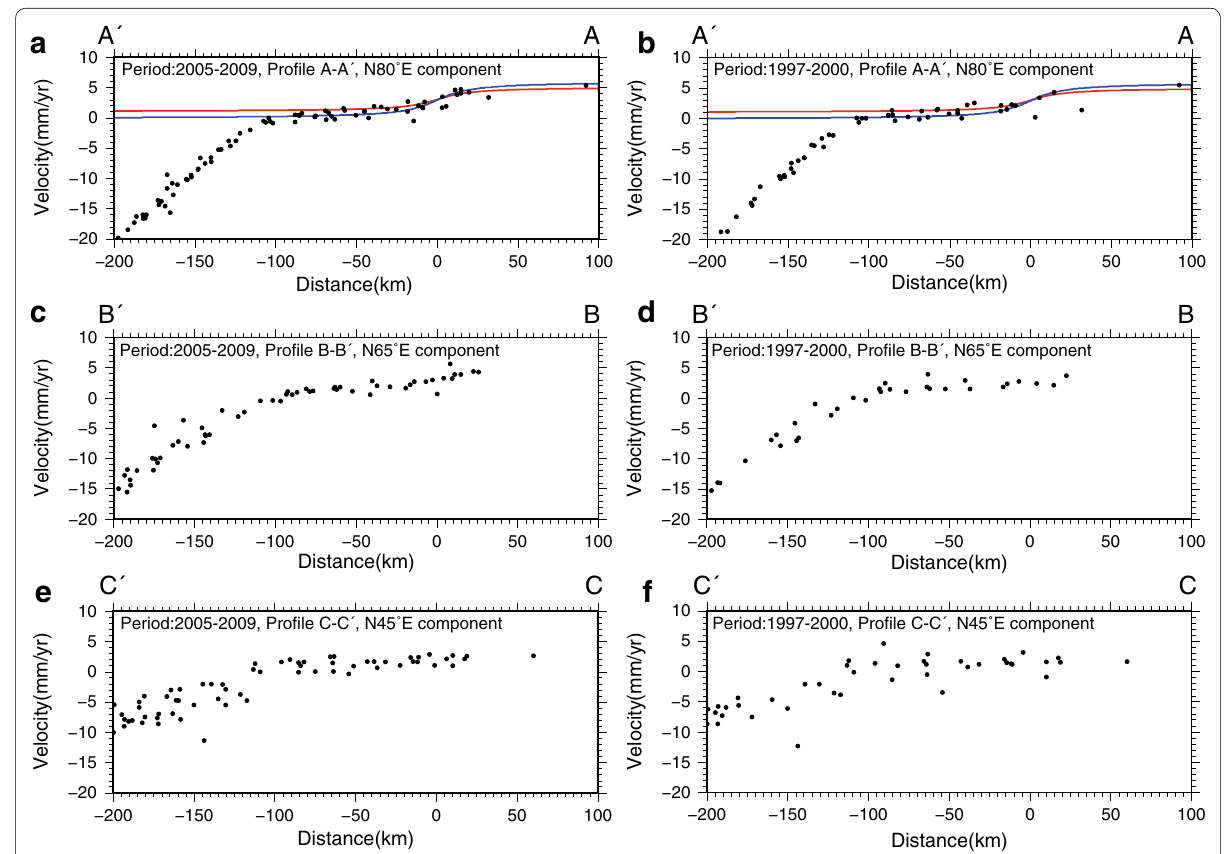
Fig. 2 Velocity profile across the NCSZ. Plotted velocities show a component perpendicular to the profiles. a Velocities along profile A – A ′ from April 2005 to December 2009. Red and blue curves are calculated velocities of elastic dislocation models for a vertical strike slip fault with a creeping rate of 4 and 6 mm/year, respectively. b Same as a but from July 1997 to June 2000. But profile B – B ′ . c Velocities along profile B – B ′ from April 2005 to December 2009. d Same as c but from July 1997 to June 2000. e Velocities along profile C – C ′ from April 2005 to December 2009. f Same as c